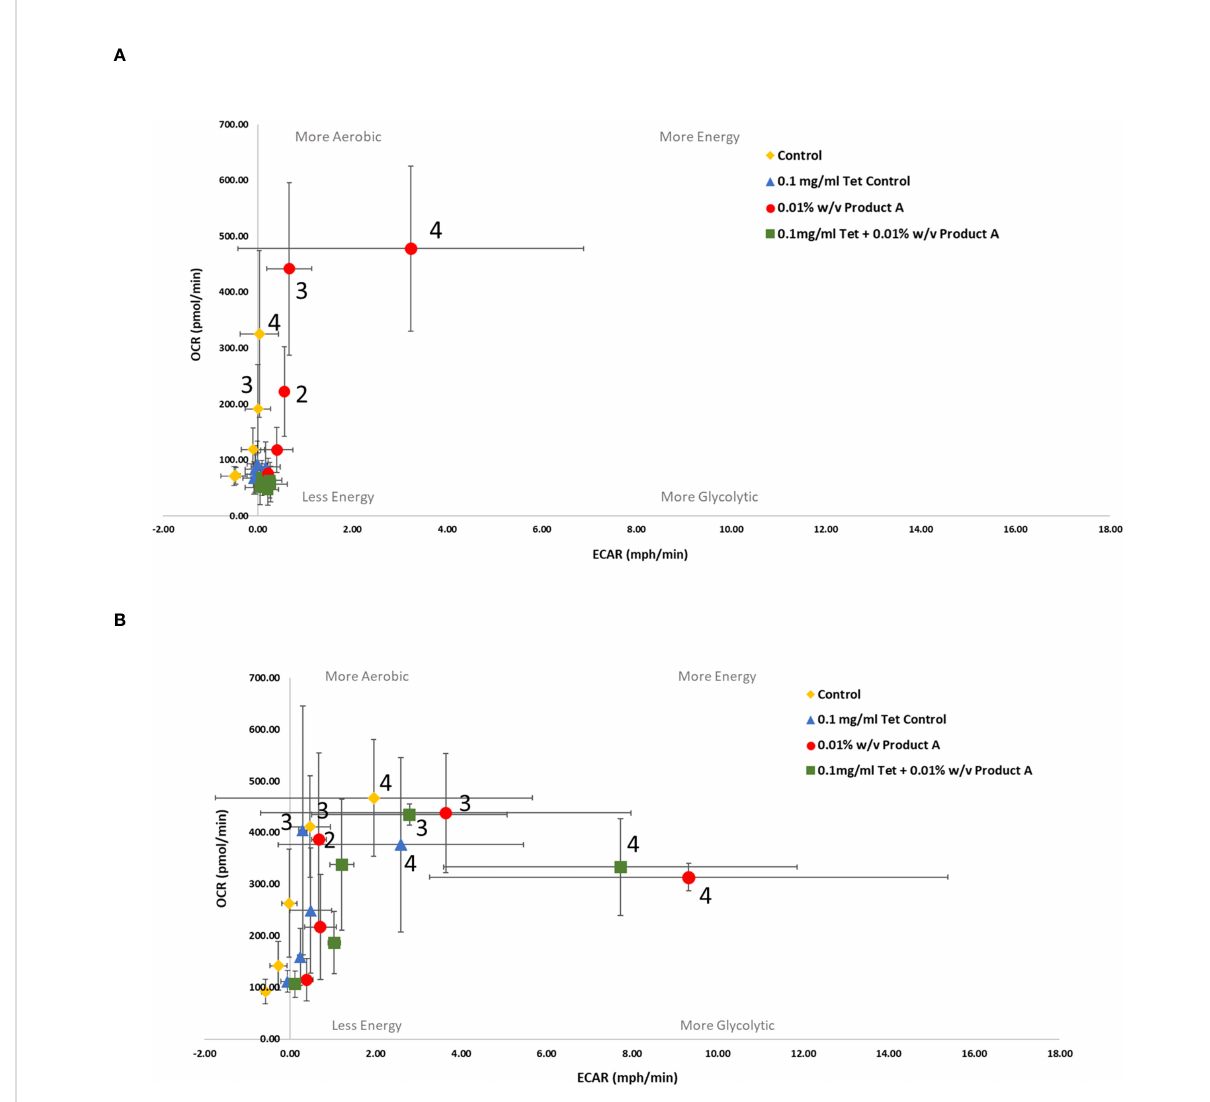
FIGURE 2 Bioenergetic real time changes in OCR/ECAR ratio of (A) antibiotic susceptible E. coli and (B) antibiotic resistant E. coli when treated with YPPA. Numbered data points represent the following time-points (0) 14 mins (1) 52 mins (2) 98 mins (3) 149 mins (4) 201 mins. Several data points have been labelled with their representative time-points for ease of results visibility. Each value was expressed using mean of triplicates for each biological replicate (n=3), error bars are representative of standard deviation. Control refers to no product/tetracycline supplementation. Product A =